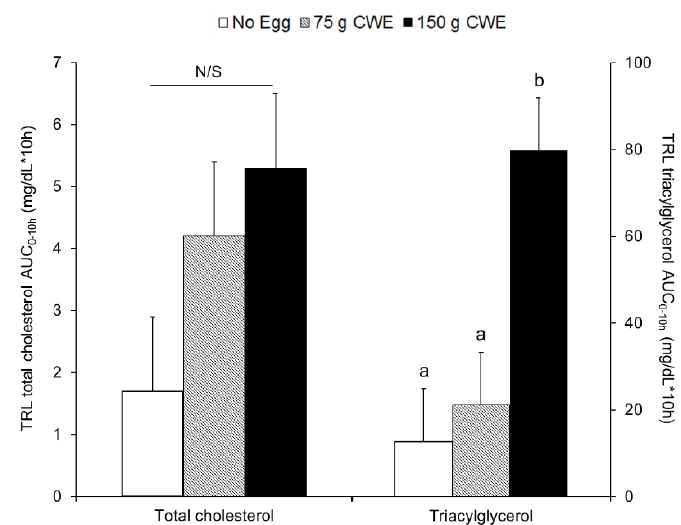
Figure 2. Total cholesterol and triacylglycerol AUC 0 – 10h within TRL fractions in study 1. Values are lsmean ± SE and different superscript letters (a, b) indicate statistical differences among no egg, 75 g CWE, and 150 g CWE ( p = 0.0006). AUC, areas under the curve; CWE, cooked whole egg; N/S, not significant; TRL, triacylglycerol-rich lipoprotein.